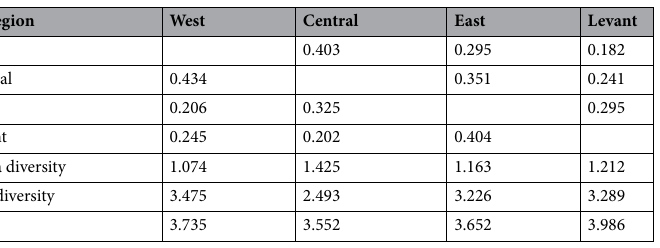
Table 1. Indexes of faunal similarity among particular longitudinal subregions in species composition (Jaccard index - upper triangle) and dominance structure (Renkonen index - lower triangle), supplemented with mean values of alpha and beta diversity and values of within-region (gamma) diversity expressed by Shannon diversity index (H’).